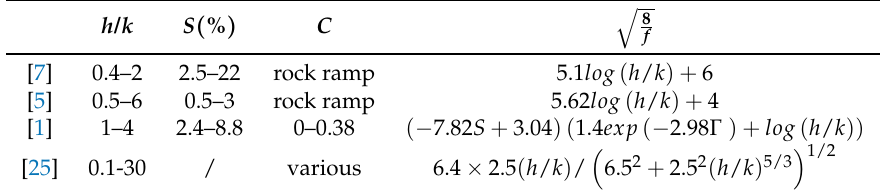
Table 2. Hydraulic conditions and experimental correlation for rock ramp